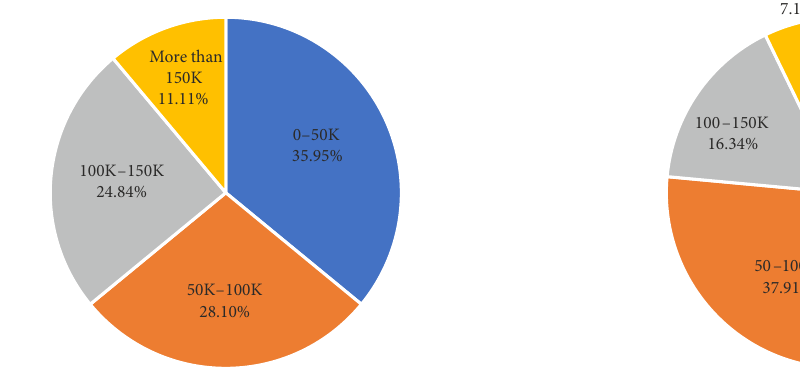
Figure 6. Statistics chart of BIM Software Purchase Expenses Figure 7. Statistics chart of the amount of BIM